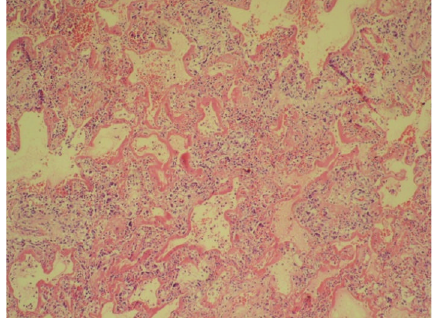
Figure 1: Prevalent hyaline membrane, H&E × 100.